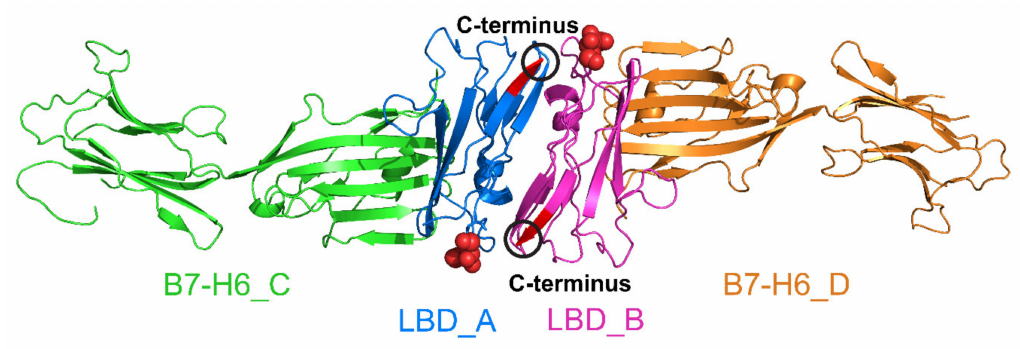
Figure 9. A dimer of the NKp30_LBD:B7-H6 complex is observed in the presented crystal structure. Within the NKp30:B7-H6 complex, both pairs of molecules bind to each other almost identically, and the binding mode of the two proteins is also very similar to that described based on the previously published structure of the complex (PDB 3PV6) [20]. However, the structure of the NKp30_LBD dimer is distinct to the previously published structure of NKp30_LBD itself (PDB 3NOI) [19]. The dimer has a two-fold rotation symmetry, and the N -glycosylation site at Asn42 of LBD_A (GlcNAc residue highlighted as spheres) is close to C-terminus of LBD_B (highlighted in red) and